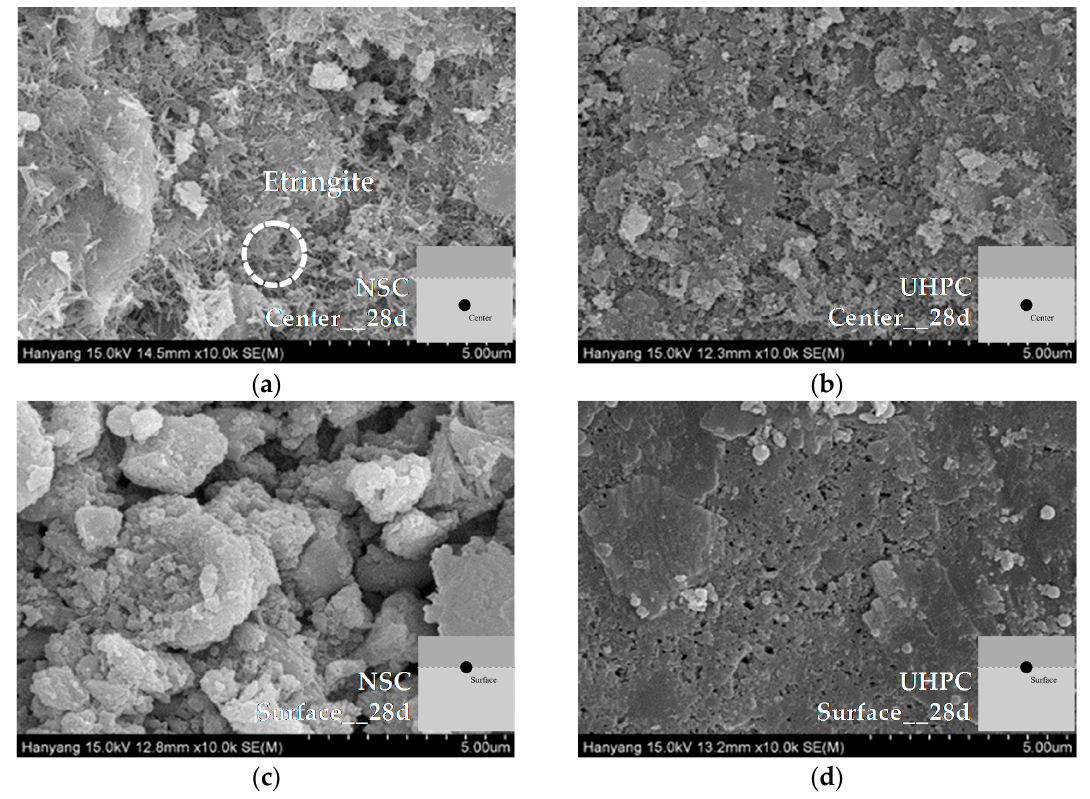
Figure 10. SEM analysis of middle sections and cold joint surfaces of NSC and UHPC (aged for 28 days): ( a ) middle section of NSC; ( b ) middle section of UHPC; ( c ) cold joint surface of NSC; and ( d ) cold joint surface of UHPC.